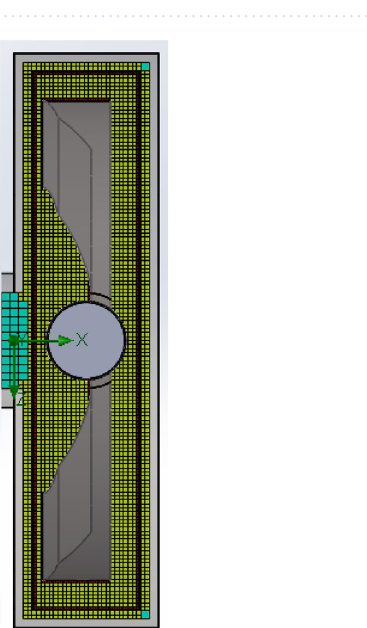
Figure 3. Simplified simulated representation and mesh settings of BCR equipment.